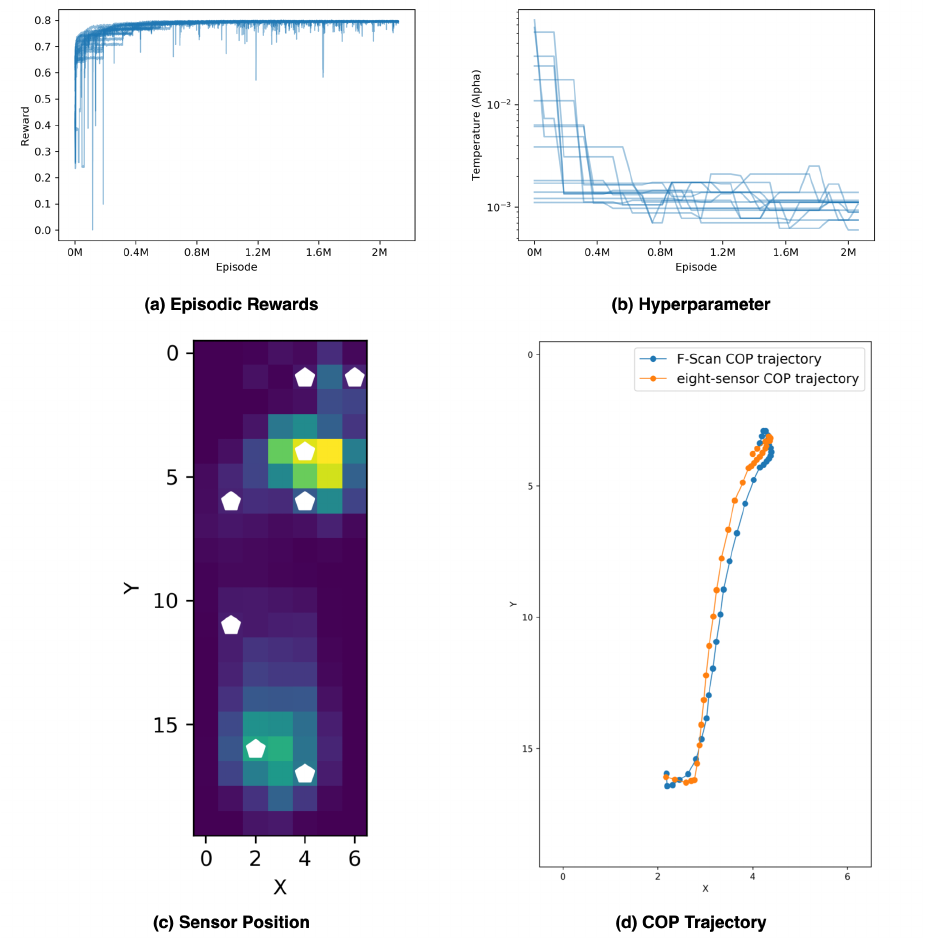
Figure 8. Illustrate the result of applying the sensor placement environment for self-selected speed running tasks. ( a ) is the episodic rewards for 15 agents and filtered with a moving average filter with a window size 1000; ( b ) displays each agent’s temperature hyperparameter with a log scaling; ( c ) presents the final designed sensor position from the best agent within the population, and the background is a pixel-wise accumulated stance-phase image; ( d ) shows the difference between the COP trajectory from the F-Scan System and our designed eight-sensor